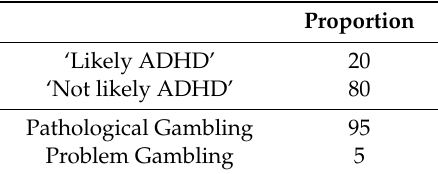
Table 2. ADHD and gambling